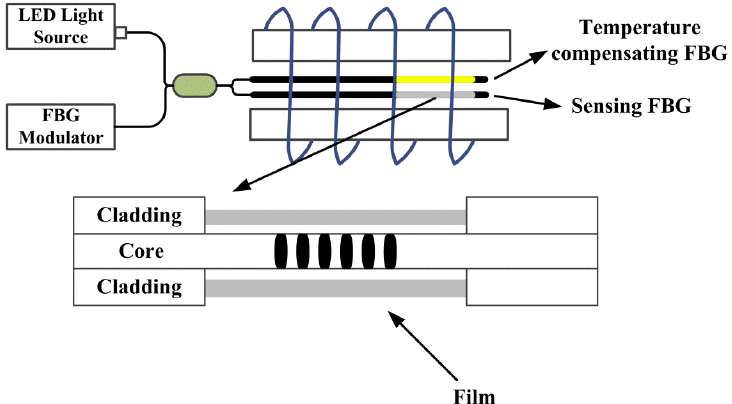
Figure 15. Configuration of optical fiber magnetic sensor used by Yang et al.